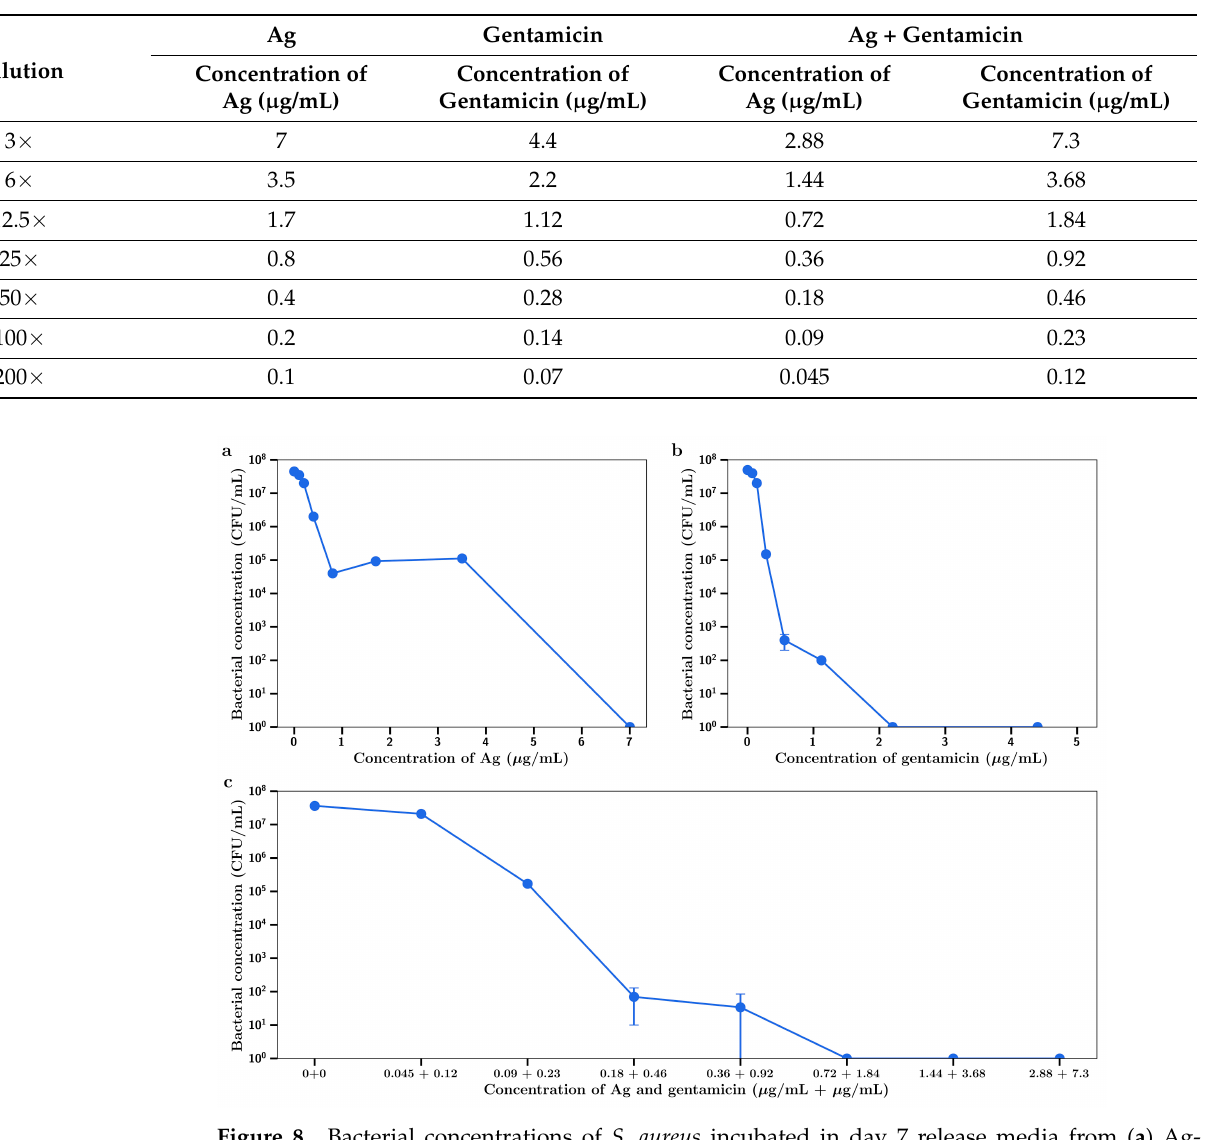
Figure 8. Bacterial concentrations of S. aureus incubated in day 7 release media from ( a ) Ag-releasing bone cement, ( b ) gentamicin-releasing bone cement, ( c ) Ag + gentamicin-releasing bone cement ( n = 3).